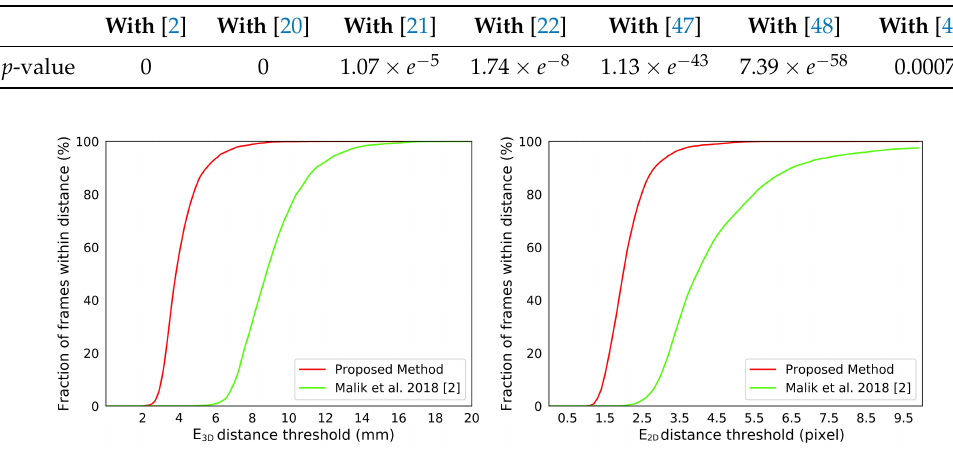
Figure 23. The E 3 D and E 2 D comparisons between our system with Malik et al. [2] on the NYU